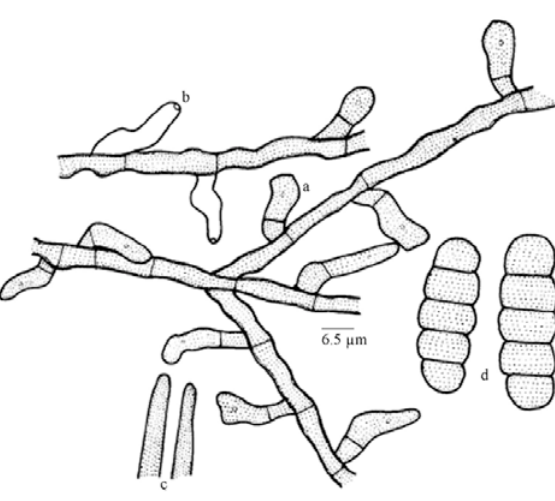
Figure 103. Meliola oleacearum a - Appressorium; b - Phialide; c - Apical portion of mycelial setae; d -